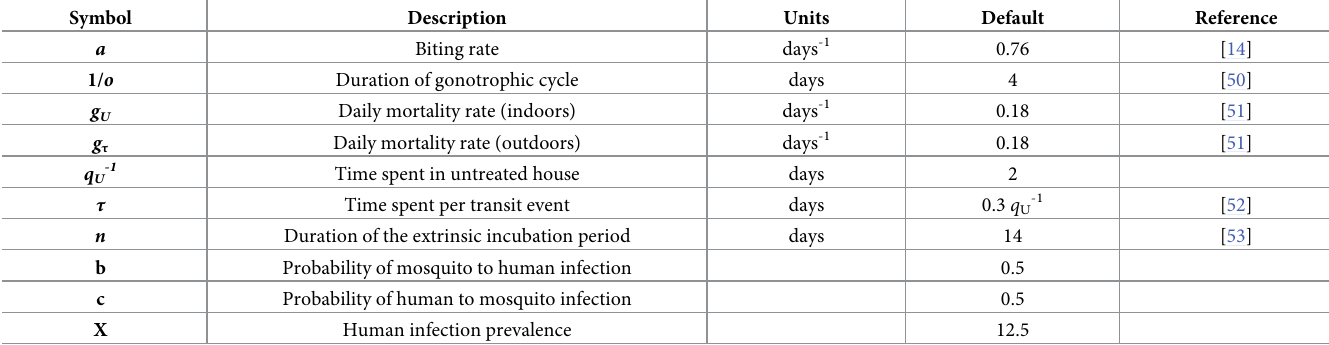
Table 1. Baseline parameters for force of infection framework.